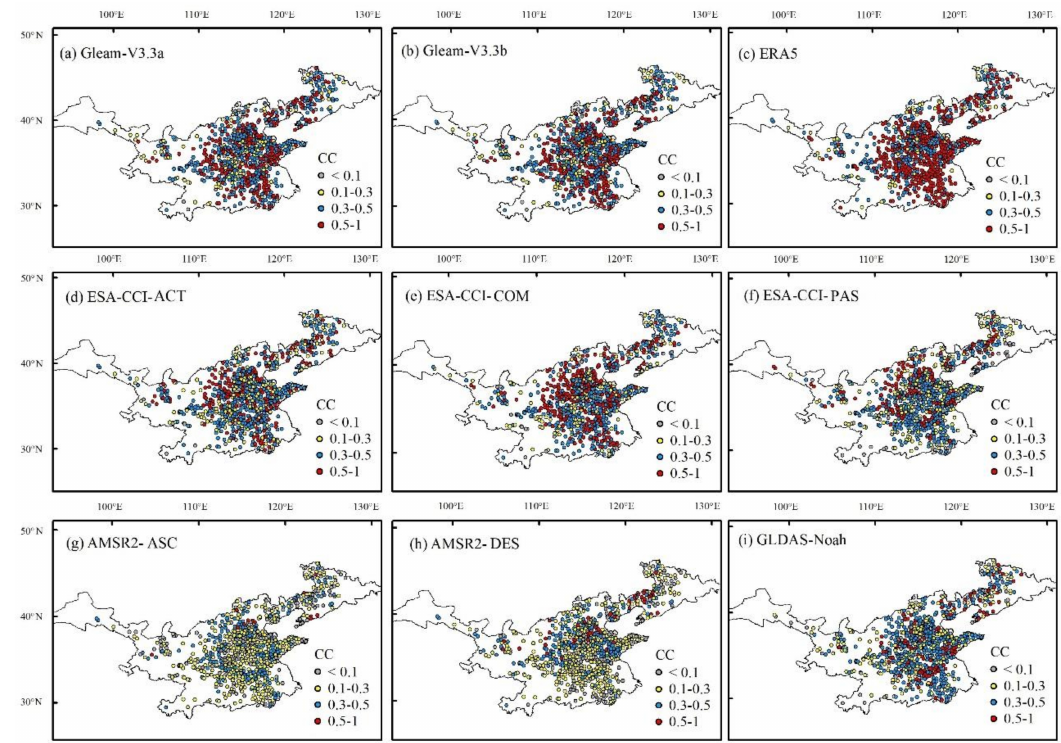
Figure 6. Spatial distribution of correlation coefficient (CC) between multi-source SM products and in situ ground observations. Four classes are included in CC evaluation: <0.1, uncorrelated; [0.1, 0.3), weak correlation; [0.3, 0.5), medium correlation; [0.5, 1], strong